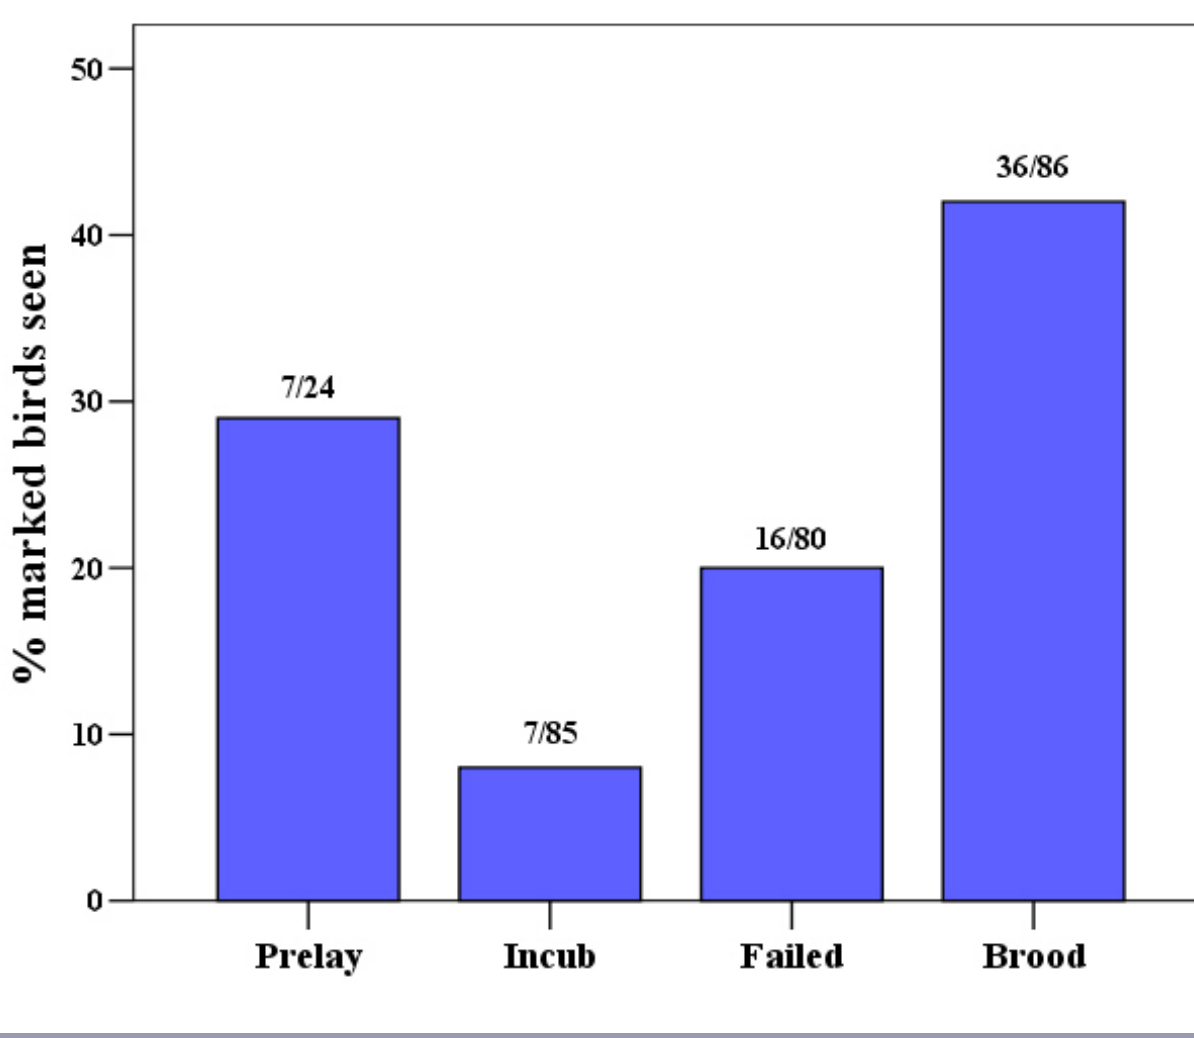
Fig. 2. Percentage of marked birds of specific breeding stages known to have been present in the survey area (Kitsim, 10 km east of Brooks, Alberta), that were observed during the survey. Data from willets and marbled godwits combined, and data from 1995 to 1998. Small numbers above bars refer to the fraction of birds seen of all available in that category. “Prelay” refers to the total number of marked birds that later (within 2 wk) incubated a nest in the survey route area; “Incub” refers to the total number of marked birds known to have an active nest in the survey route area; “failed” is the total number of marked birds with recently failed nests, whose nests had been in the survey route area; “brood” is the total number of marked adults attending broods that had been seen in the survey route area within 3 d of a survey date (by independent brood